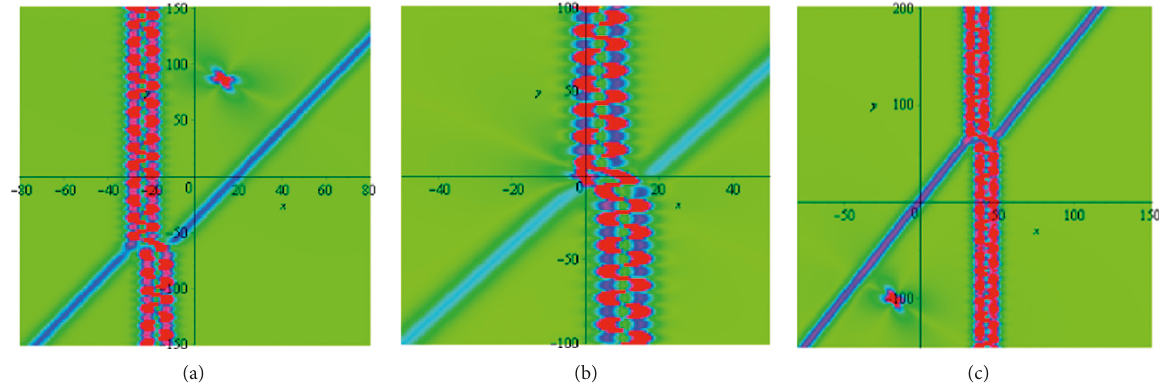
Figure 26: Plots of equation (89) by considering ϕ (b) f 2. (c) f 3.